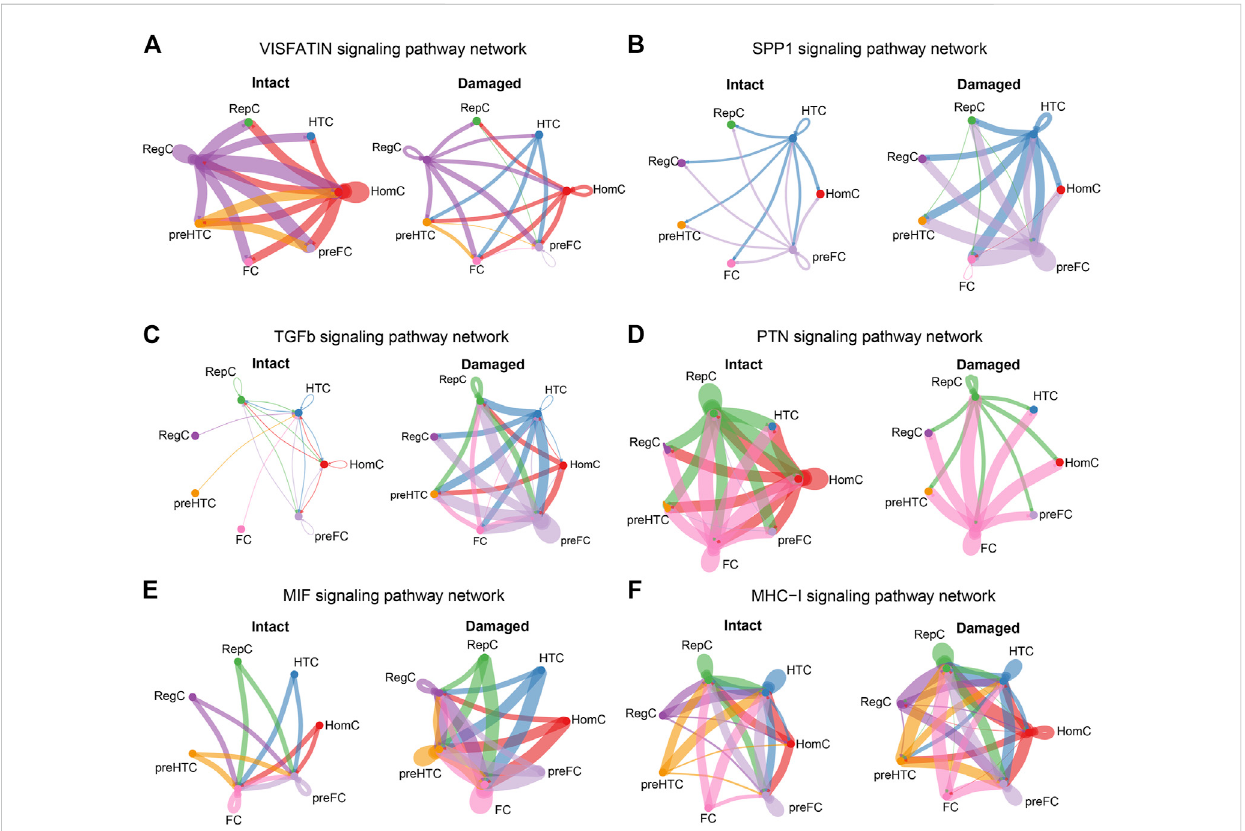
FIGURE 7 Cellular communications among the chondrocyte subtypes are signi fi cantly altered in the damaged cartilage compared to those in the intact cartilage samples. The circle plots show the obvious changes in cell communication mediated by VISFATIN (A) , SPP1 (B) , TGF- β (C) , PTN (D) , MIF (E) , and MHC-I (F) signalingpathways.Coloreddotsrepresentdifferentcellssubtype.Thethicknessofthelinesrepresentsthestrengthofcellconnection,thicker the line the stronger the